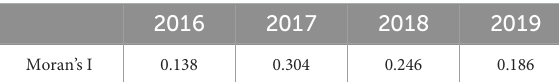
TABLE 3 Distance-based global Moran’s I from 2016 to